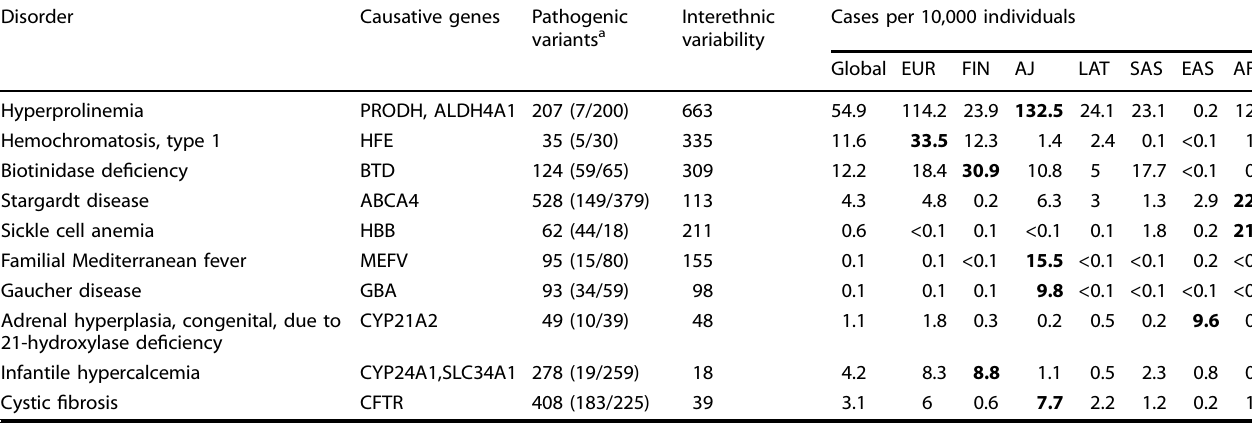
Table 1. Population-speci fi c prevalence of ten common autosomal recessive disorders.